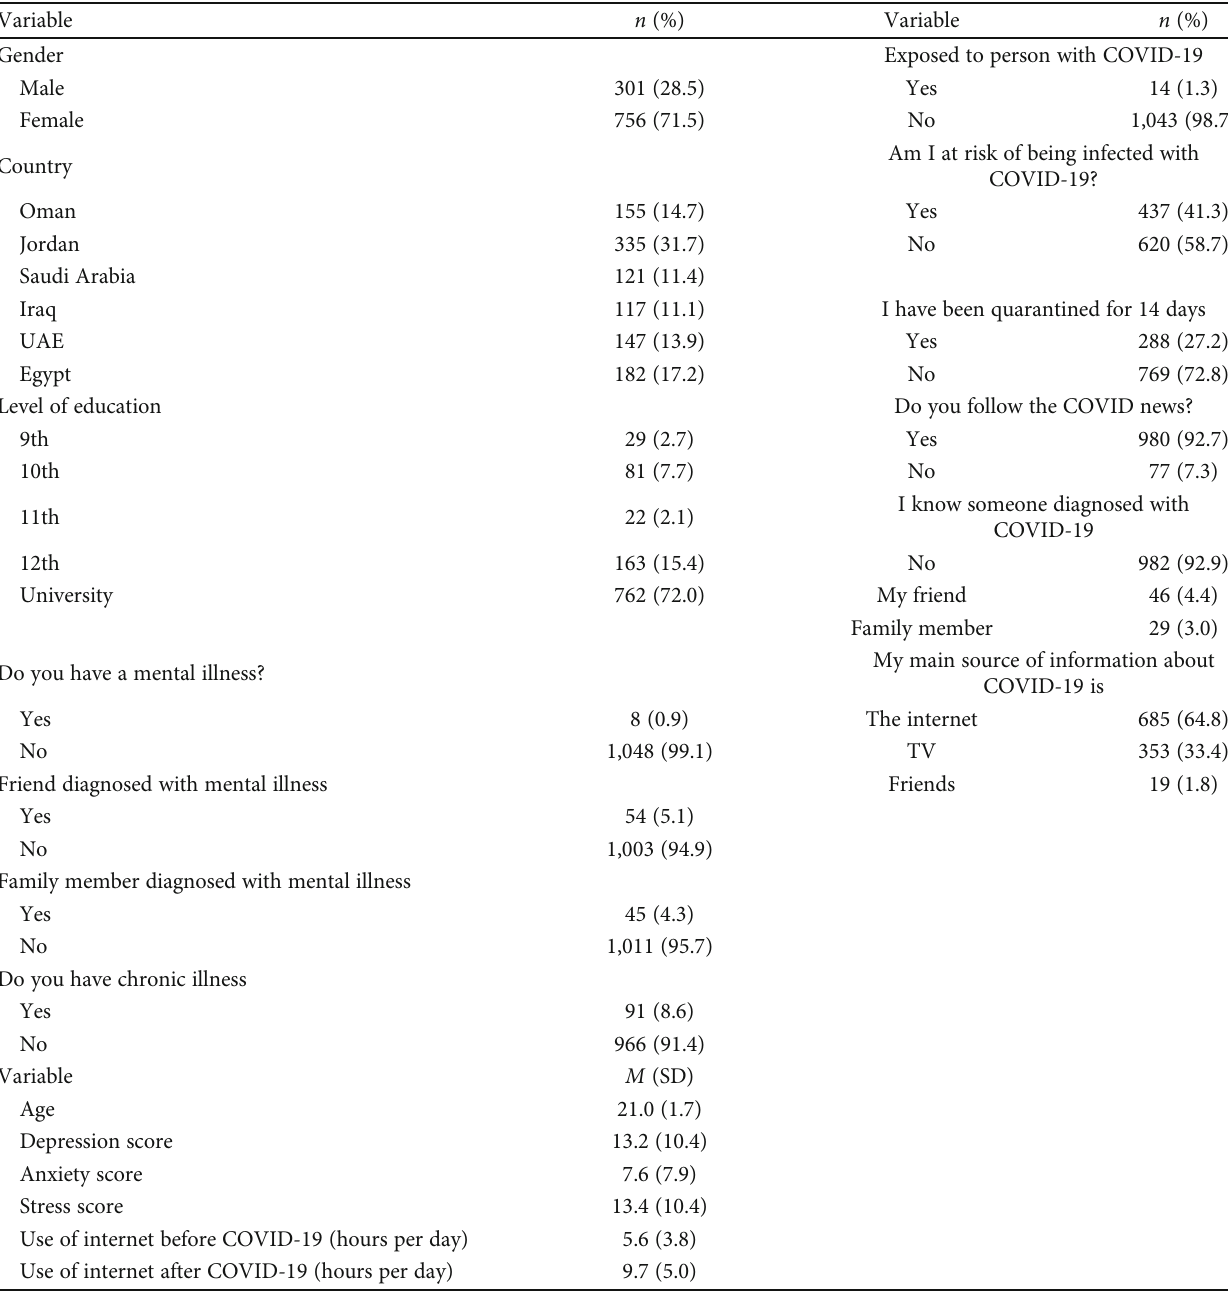
Table 1: Sample characteristics ( N = 1,057